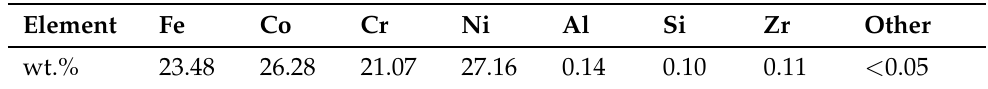
Table 1. Chemical composition of CoCrFeNi powder, analysed using XRF (AMG Superalloys UK) taken from work by Brif et al. using the same powder